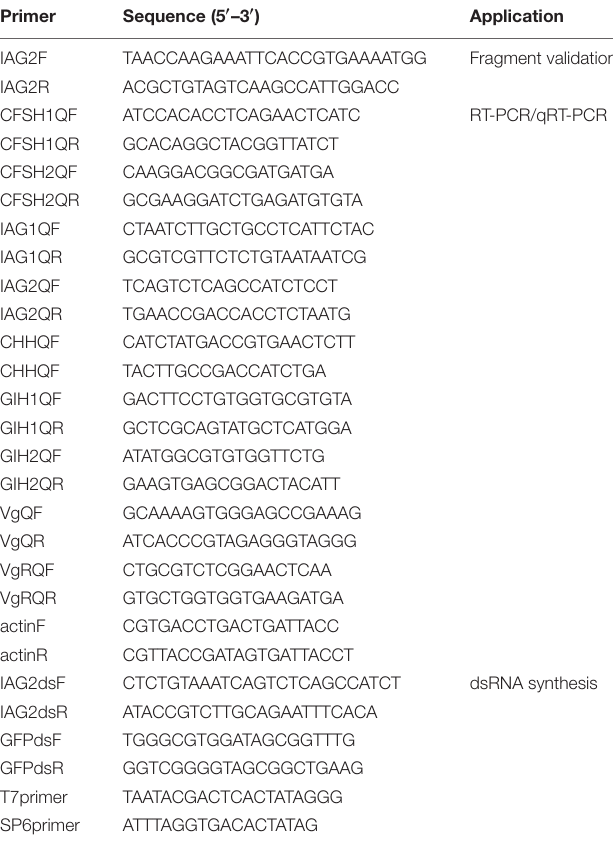
TABLE 1 | Summary of primers used in this